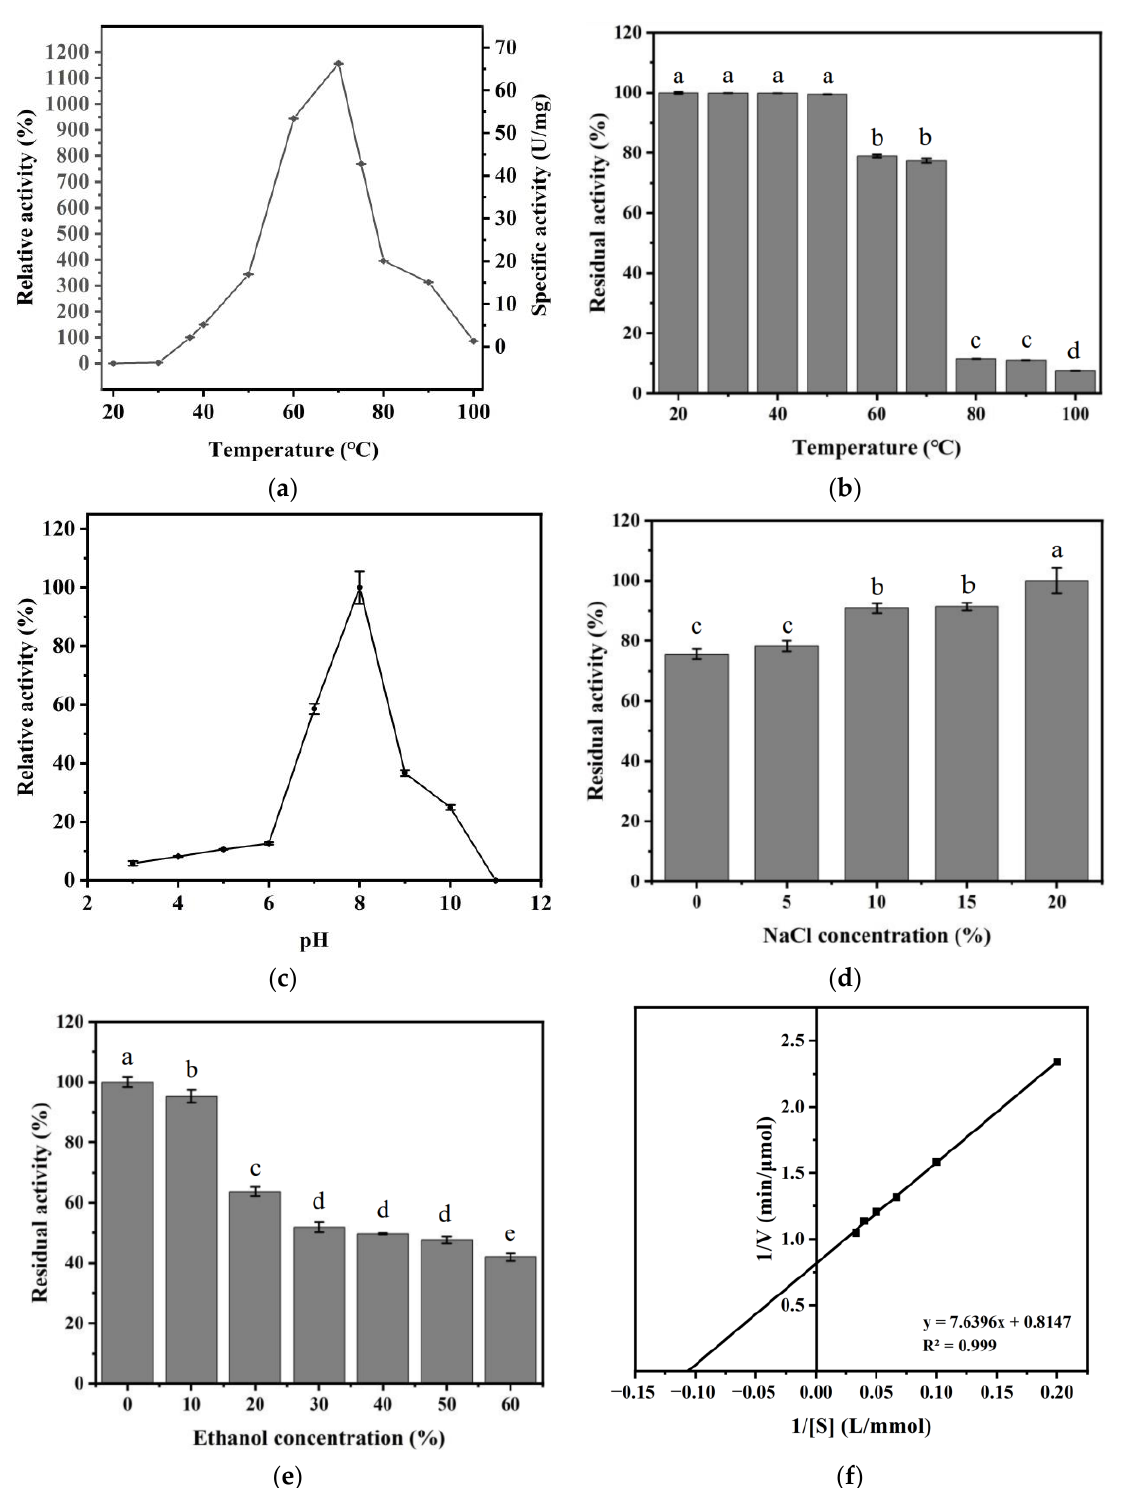
Figure 2. Enzymatic properties of ECH in different conditions. ( a ) Effects of temperature on ECH activity; ( b ) effects of temperature on ECH stability; ( c ) effects of pH on ECH activity; ( d ) effects of NaCl on ECH activity; ( e ) effects of ethanol on ECH activity; ( f ) Lineweaver -Burk plots of purified ECH. Letters a, b, c, d and e was used to show statistically significant differences between groups. Different letter means the significant difference, same letter means not signficant difference. ( p < 0.05). Table 1. Effect of metal cations and ethylene diamine tetraacetic acid(EDTA) on activity of ethyl carbamate hydrolase (ECH).